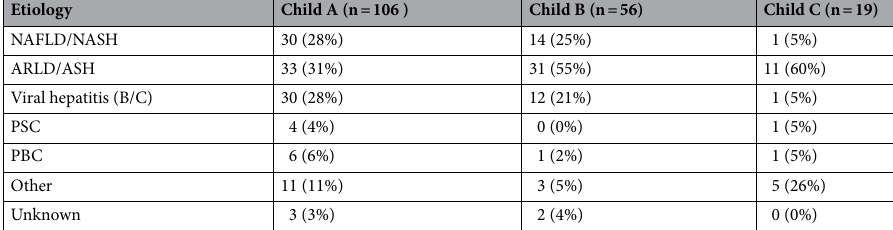
Etiology Child A (n = 106